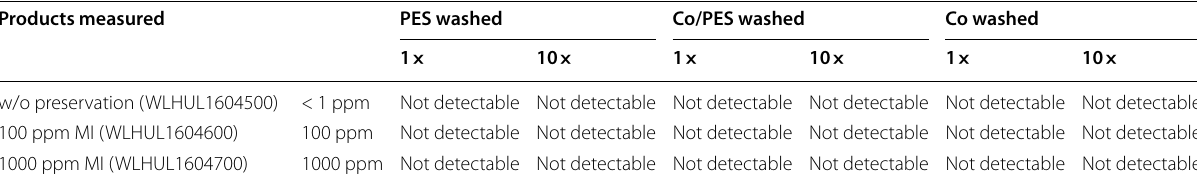
MI detection in PES, Co/PES and CO washed one time or ten times in different MI concentration (< 1, 100 and 1000 ppm). MI, 2-methyl-4-isothiazolin-3-one; Co, cotton fabric; PES, polyester fabric; co/PES, blended fabric (cotton with polyester), detection limit < 0.05 ppm